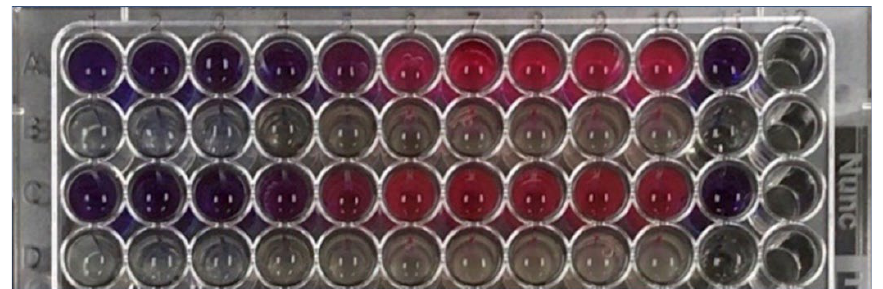
Figure 8. Antibacterial activity resazurin assay ( A , C ) and turbidity observation ( B , D ) of ZnO NS